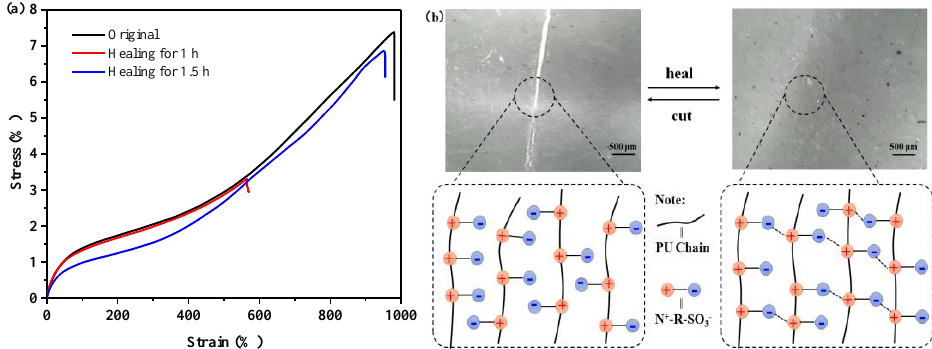
Figure 7. ( a ) Stress–strain curves of the original and healed ZPU films; ( b ) Optical microscopy images of scratched and healed ZPU films and self-healing mechanism.